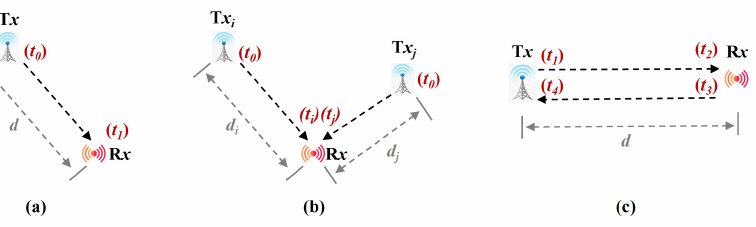
Figure 2. Time-based estimations: ( a ) Time of Arrival (ToA), ( b ) Time Difference of Arrival (TDoA) and ( c ) Round Trip Time